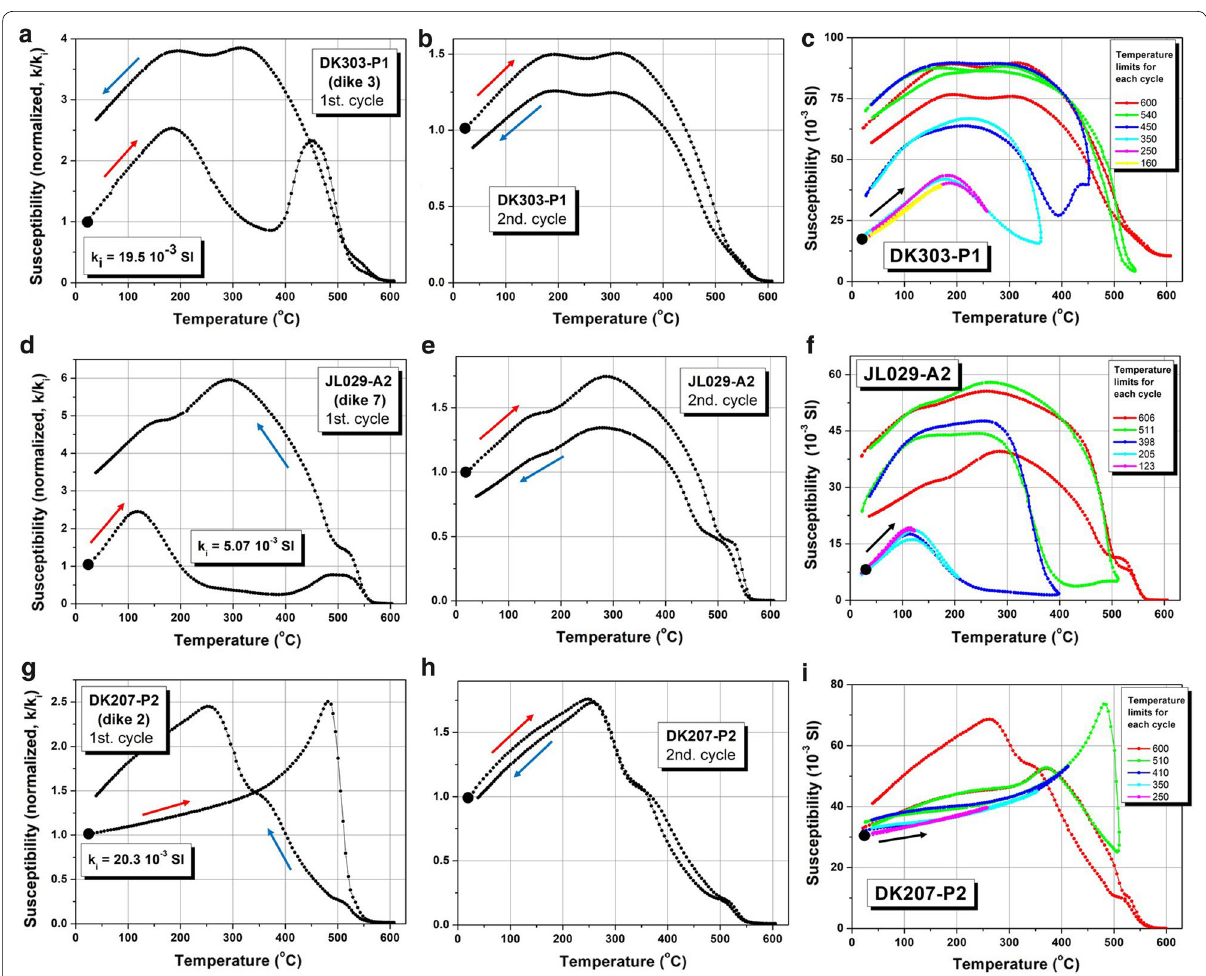
Fig. 3 Selected plots of magnetic susceptibility versus temperature ( T ) for three samples DK3 (above), DK7 (in the middle) and DK2 (below). First, heating–cooling cycles (left plots, a , d, g ) and second heating–cooling cycles (central plots, b , e , h ). The susceptibility values are normalized relative to the initial susceptibility at room temperature (ki, given on the left diagram). Right plots ( c , f , i ) show the partial heating–cooling